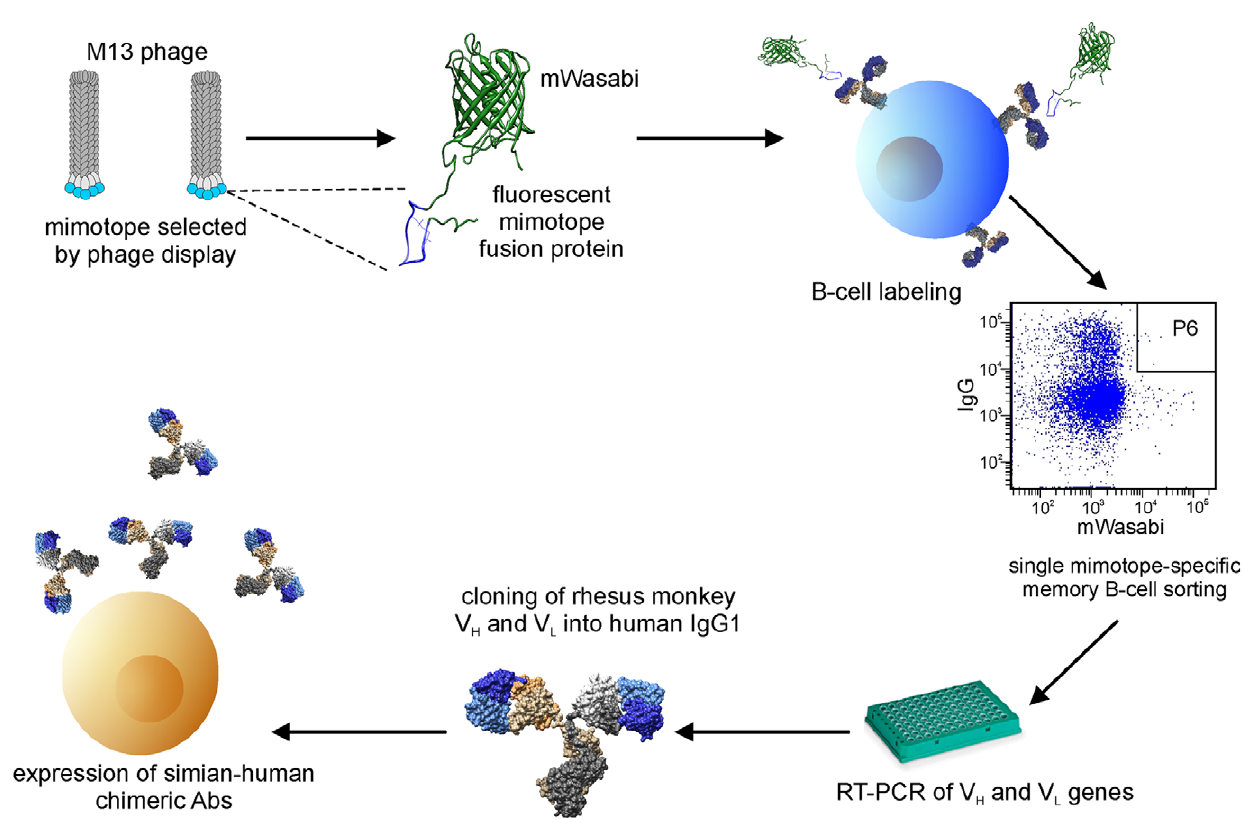
Figure 1. Strategy of isolation of epitope-specific Abs. After differential biopanning of phage display peptide library, mimotopes representing conformational epitopes are sequenced, and the inserts plus M13 flanking sequences are cloned into a bacterial expression vector encoding fluorescent protein. After purification of the resulting mimotope fusion proteins, binding assays to assure maintenance of the correct three- dimensional structure of mimotope insert are conducted. This is followed by single-cell sorting for specific IgG-positive memory B cells, single-cell RT- PCR and cloning of RM V L and V H regions into pFUSE2-type vectors encoding the backbone of human IgG1.